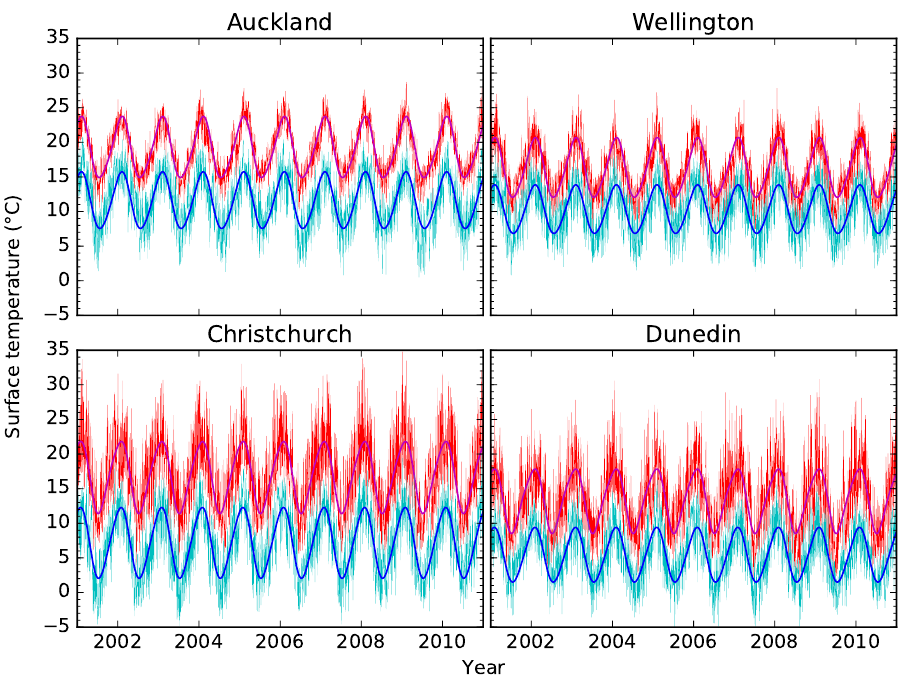
Figure 2. Observations of daily maximum surface temperature (red) and daily minimum surface temperature (cyan) from VCSN, together with the mean annual cycle obtained from the regression model fit to the daily maximum surface temperature (magenta) and the daily minimum surface temperature (blue) time series for four selected locations in New Zealand, over the period 2001 to